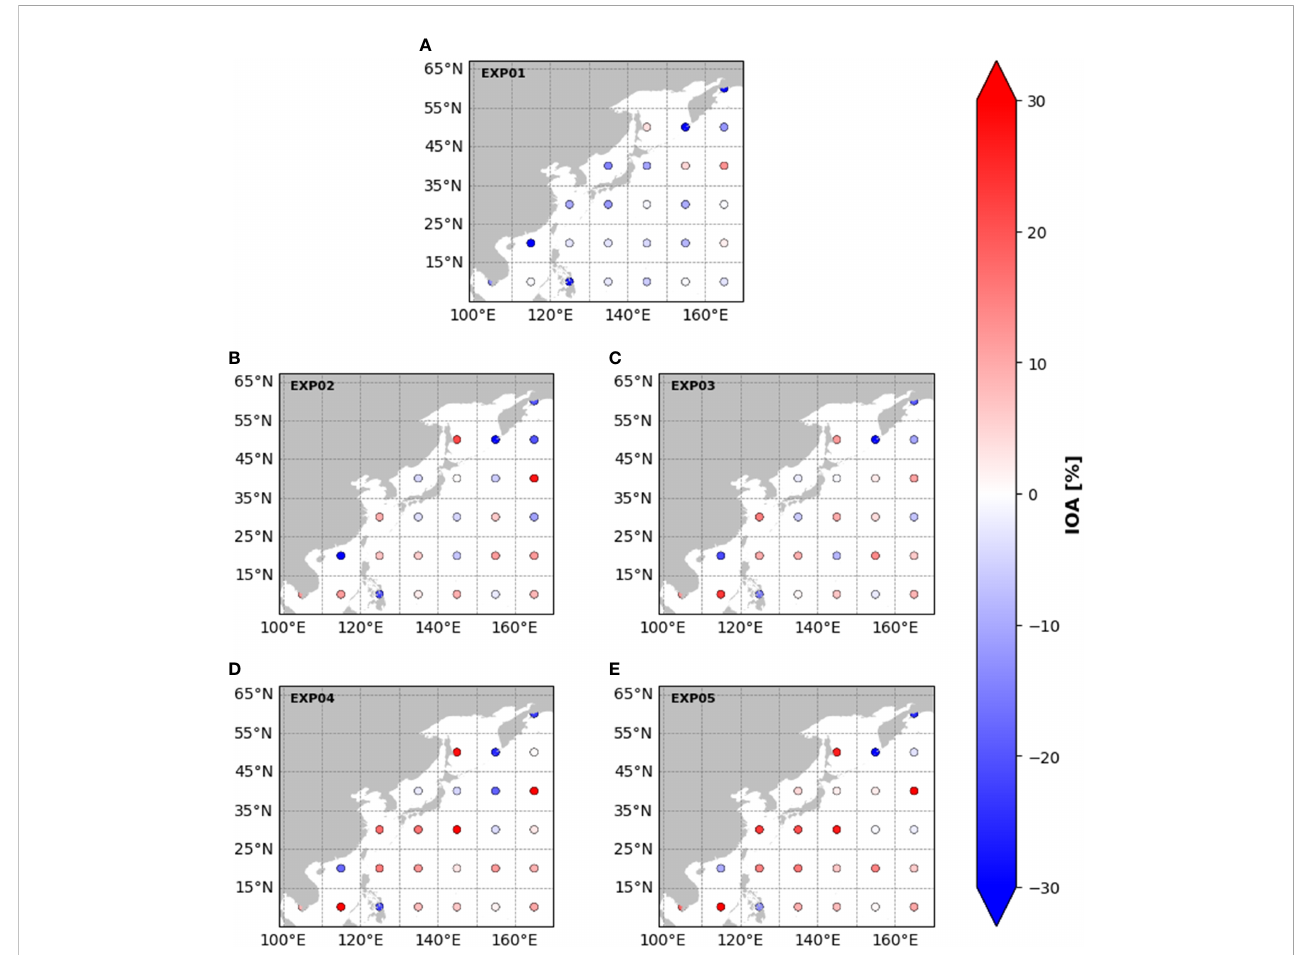
FIGURE 5 Distribution of mean IOA for temperature at subsurface layer. (A-E) represent the results of EXP01-05, respectively.